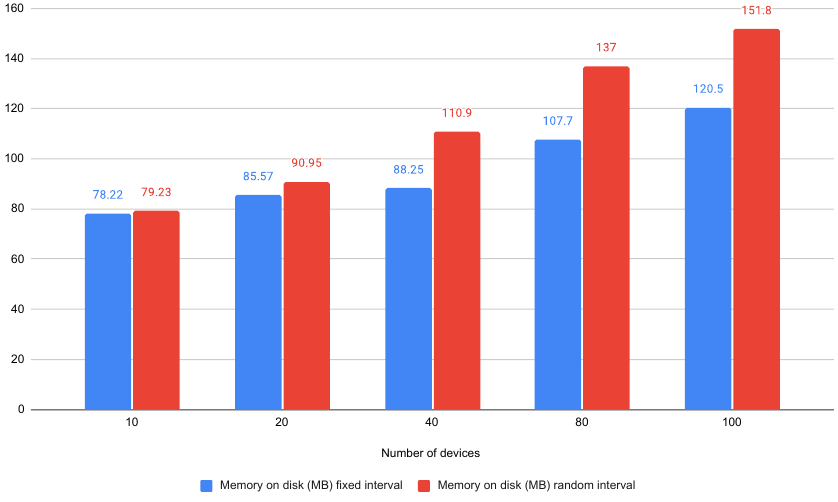
Figure 12. Storage space used by data generated for fixed time intervals vs data generated for random time